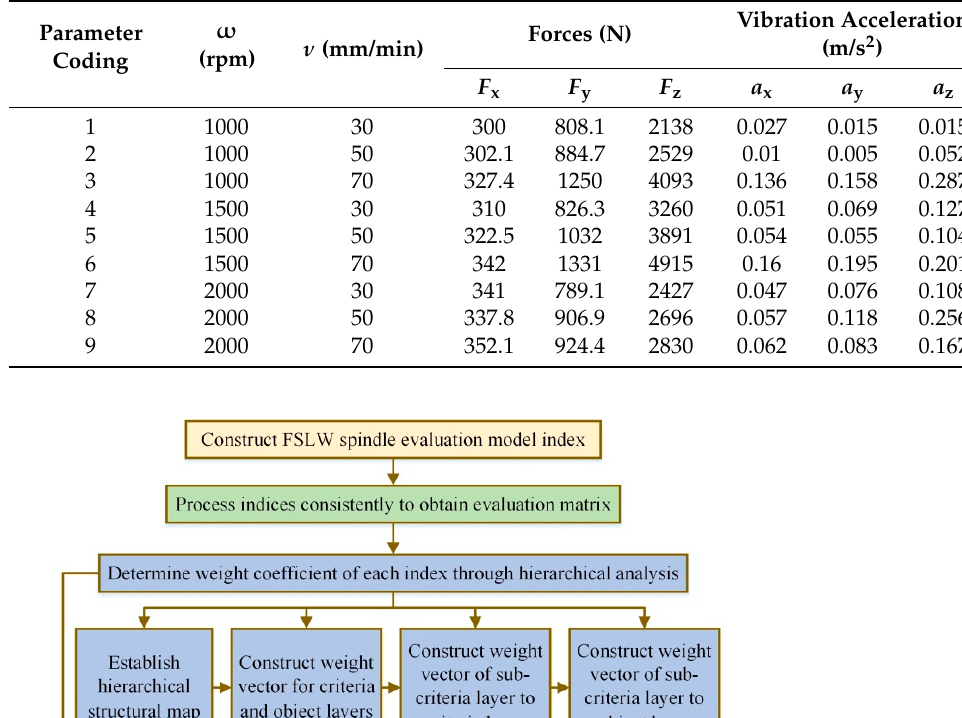
Table 2. Dynamic performance of spindle under different welding parameters.